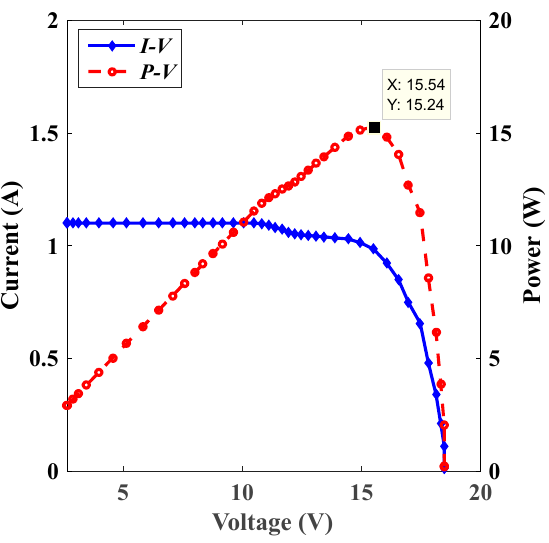
Figure 17. Practical I-V and P-V curves of the PV module.